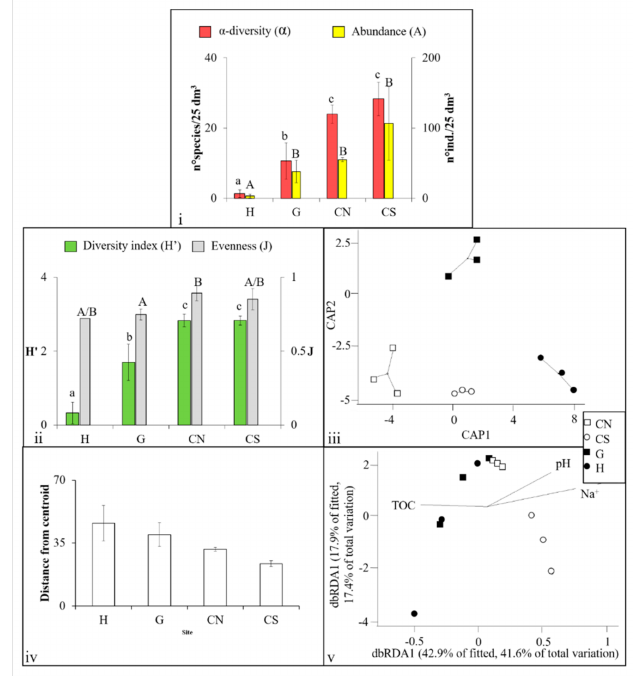
Figure 2. ( i ) α -diversity ( α ) and abundances (A) trends of Mollusca assemblages, ( ii ) diversity (H’) and evenness (J) indices trends of Mollusca assemblages. Bars with different letters (a, b, c or A, B) are related to sites showing significant di ff erences ( p < 0.05). ( iii ) Canonical Analysis of Principal coordinates (CAP) for the factor Site: straight lines are related to distances of each site replicates from their cluster centroid, formally explained in ( iv ): mean ( ± SE) multivariate dispersion (PERMDISP, small-scale heterogeneities) of the Mollusca assemblages calculate on their abundances. ( v ) The dbRDA (distance-based redundancy analysis) ordination for Mollusca heterogeneities vs. the significant explanatory environmental variables. Vector overlays represent multiple partial correlations of the explanatory variables with the distance-based redundancy analysis (dbRDA) axes. See text for further